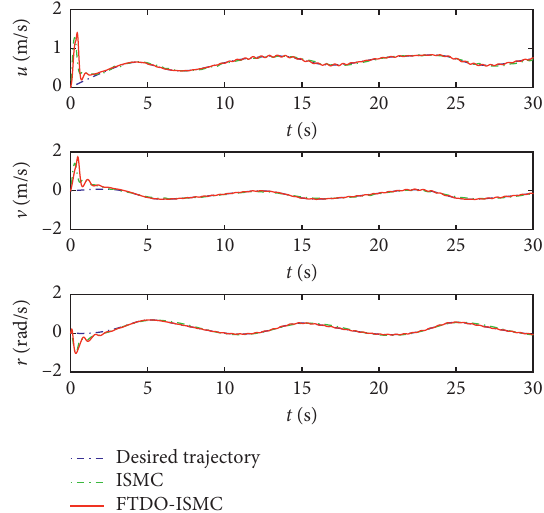
Figure 9: Velocity tracking on ISMC and